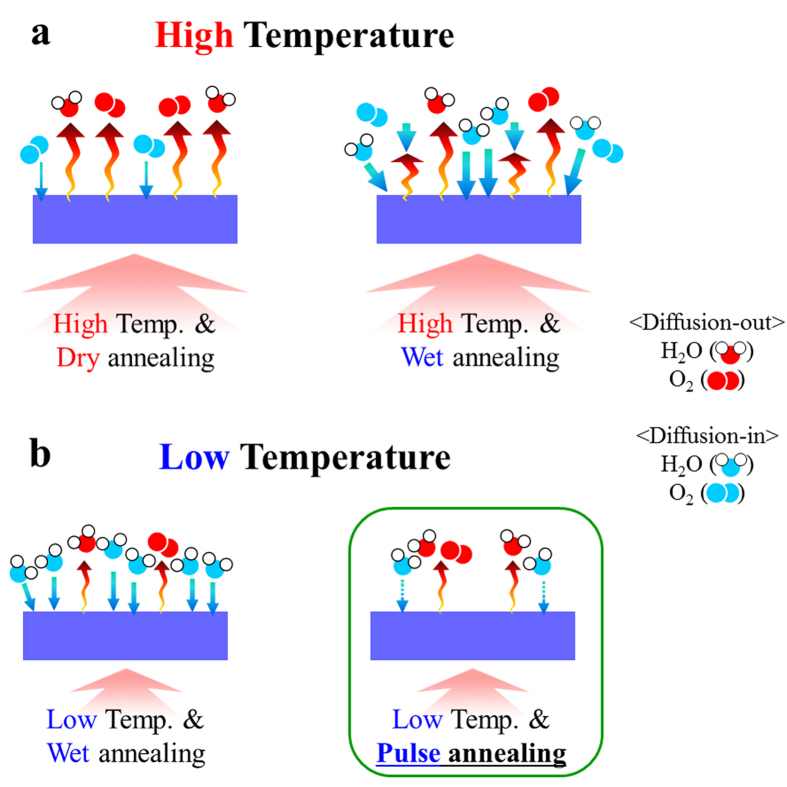
Schematic illustration of oxygen-related gas in/out diffusion mechanisms depending on thermal annealing temperature and gas ambient.(a) High temperature (>300 °C): dry and wet ambient. (b) Low temperature (<200 °C): wet and wet pulse ambient.